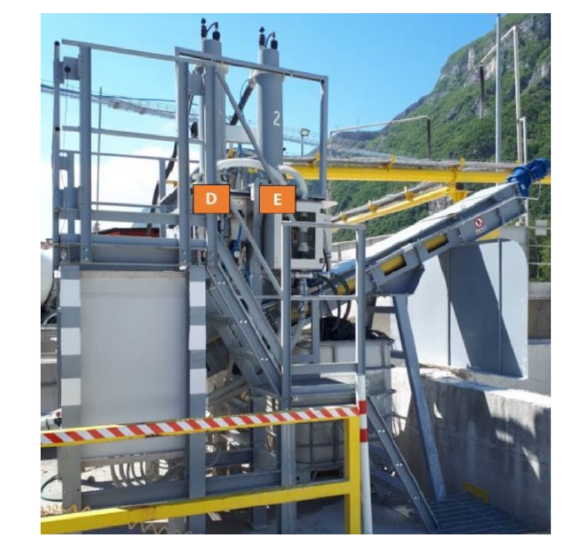
Figure 4. Cement sludge sampling